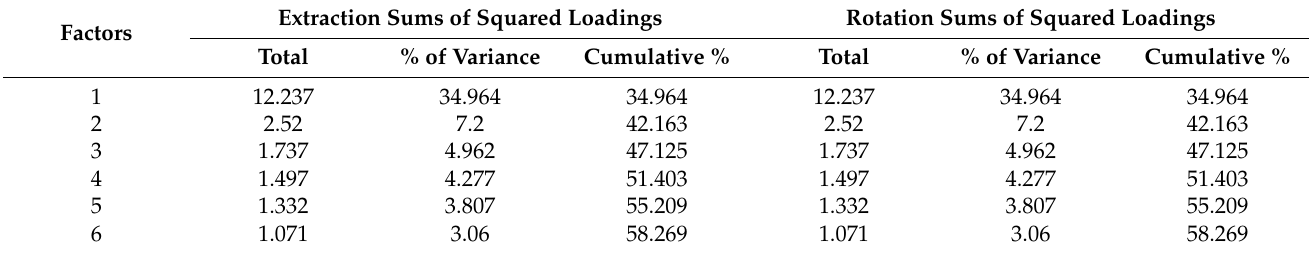
Figure 9. Eigenvalues for ordered factors of DK. Table 1. The variance explanation of